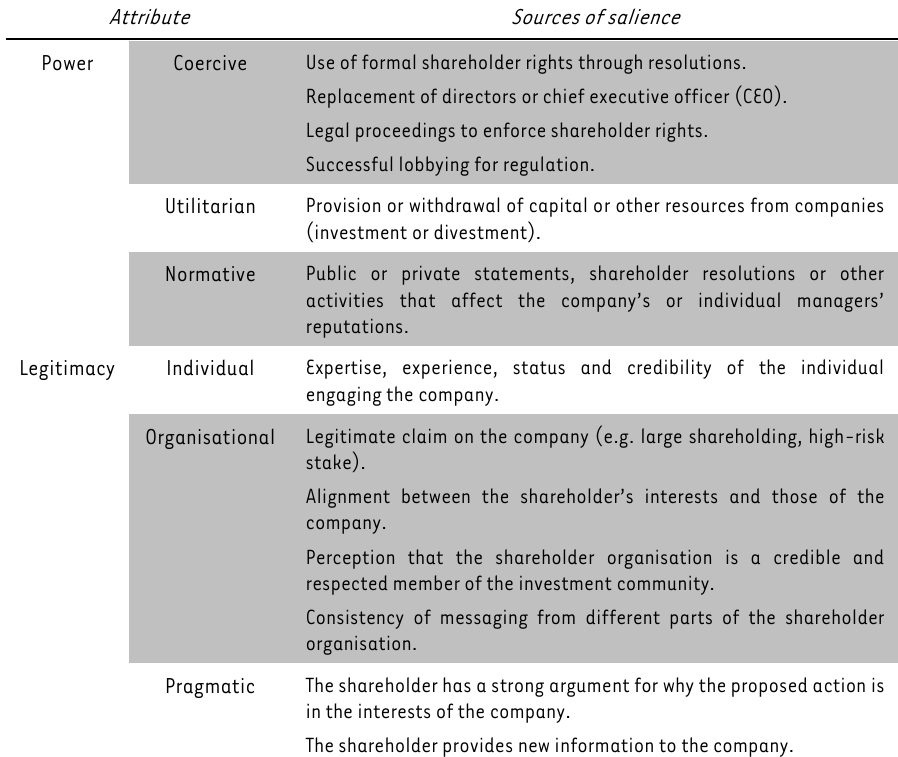
TABLE 1: Attributes of shareholder salience